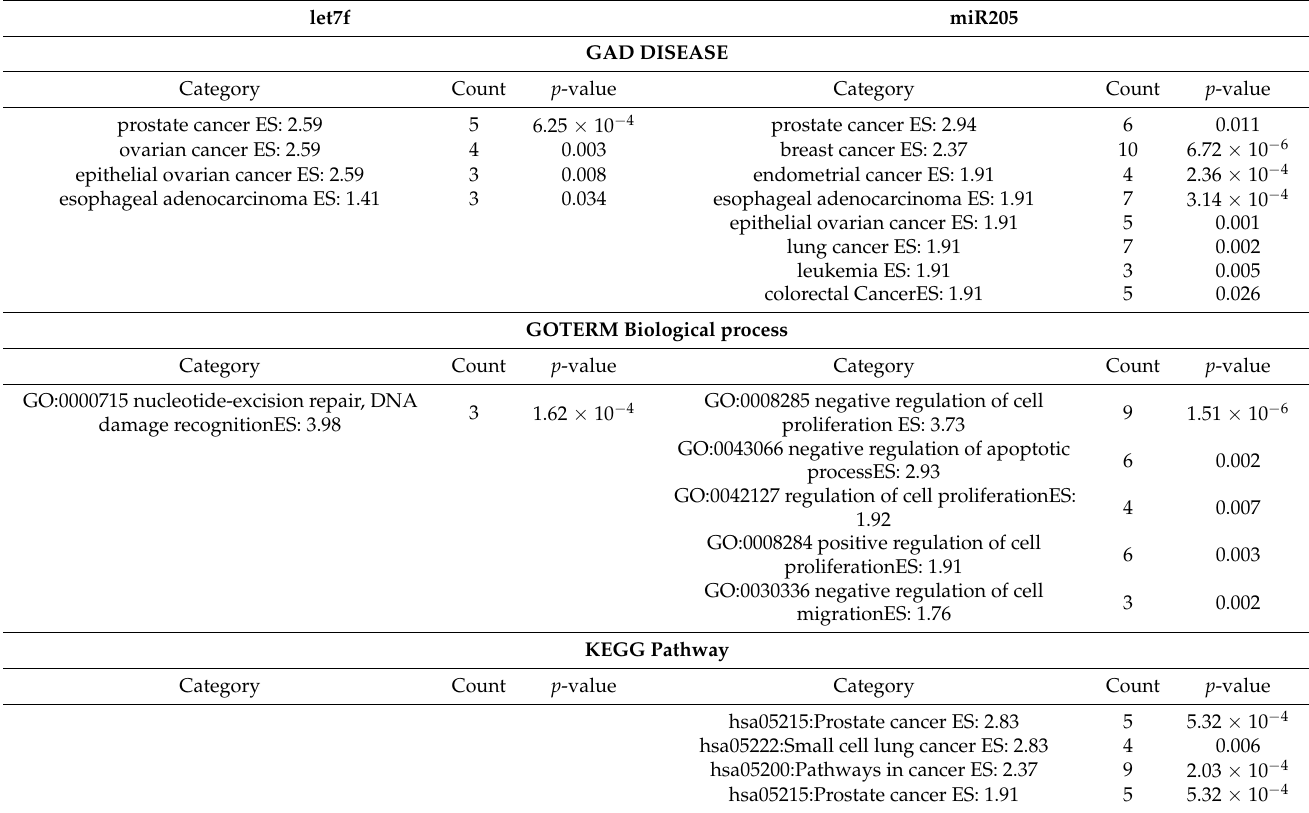
Table 1. Functional annotation clustering of let-7f-5p and miR-205-5p